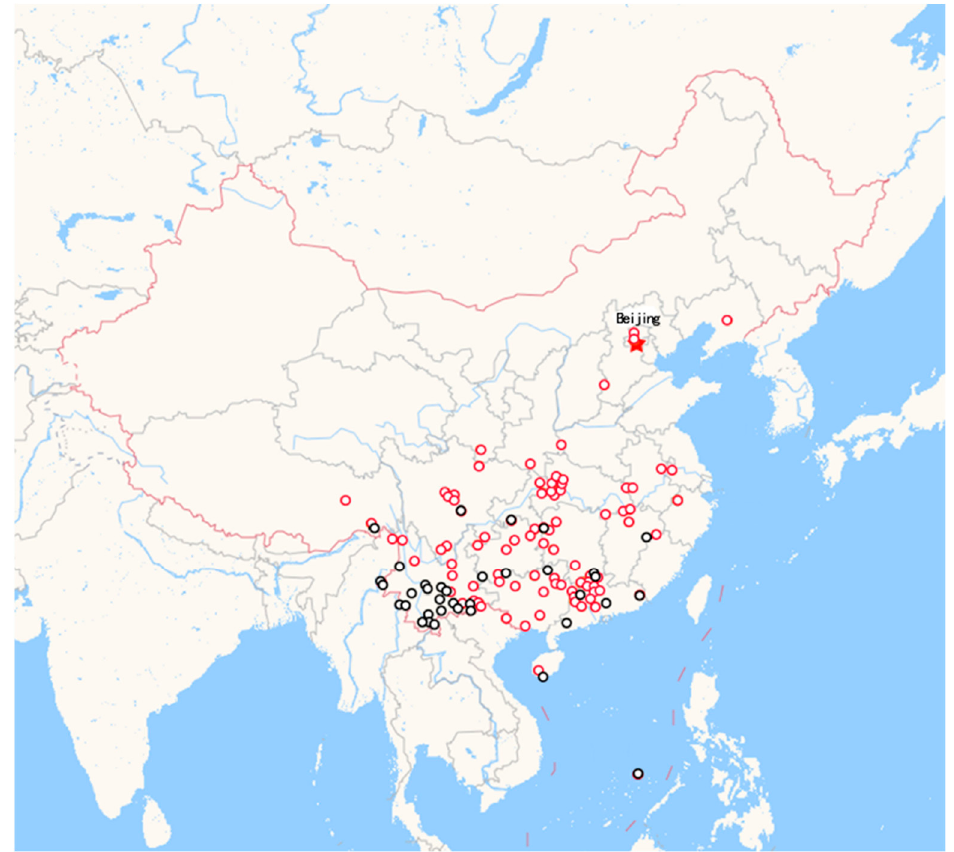
Figure 1. Different ranges of natural distributions of T. ciliata (black circles) and T. sinensis (red circles) in China. This figure was drawn by synthesizing the distribution maps of specimens of T. sinensis and T. ciliata from the Chinese Virtual Herbarium website. Distribution of each species can be searched by inputting the species names on the website. Each point represents a record of specimens collected from the corresponding position. The red star represents the position of Beijing, the capital city of China.